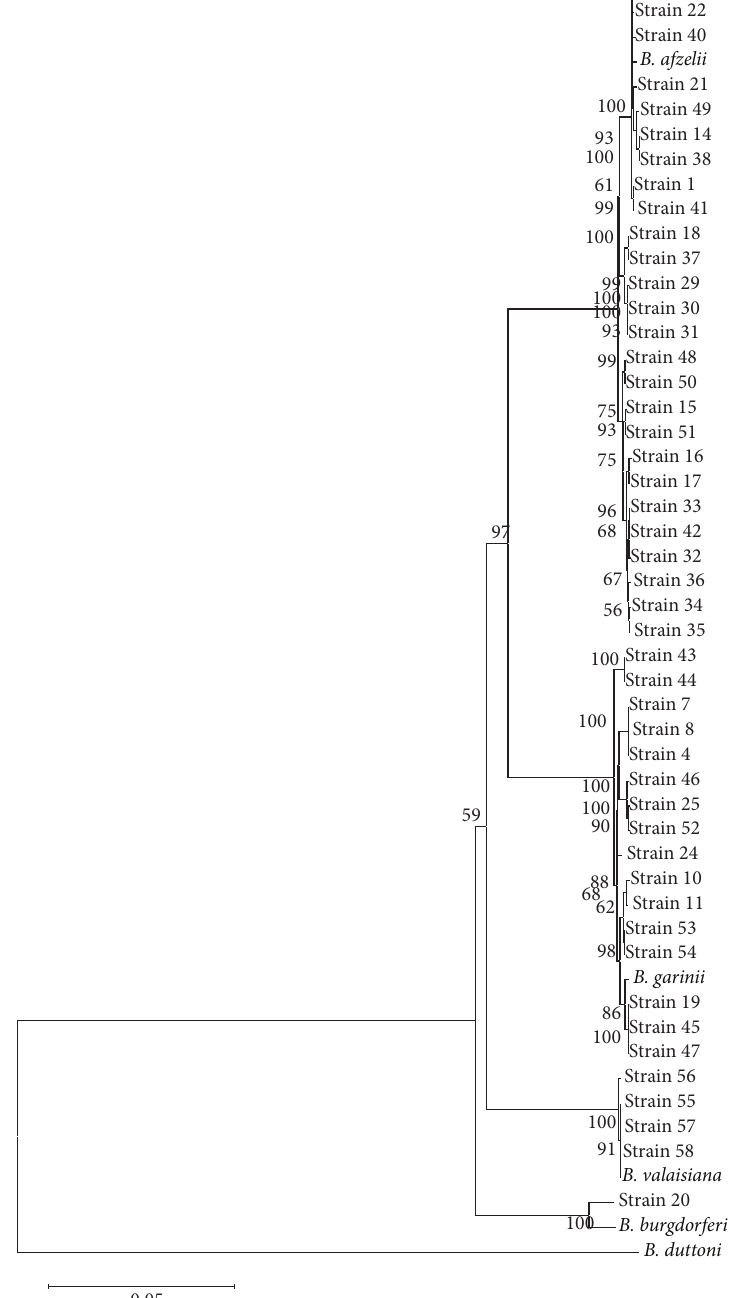
Figure 2: Description of clades based on the neighbour-joining tree (bootstrapped 500 iterations) calculated based on concatenated DNA sequences showing the relationship between B. burgdorferi s.l.